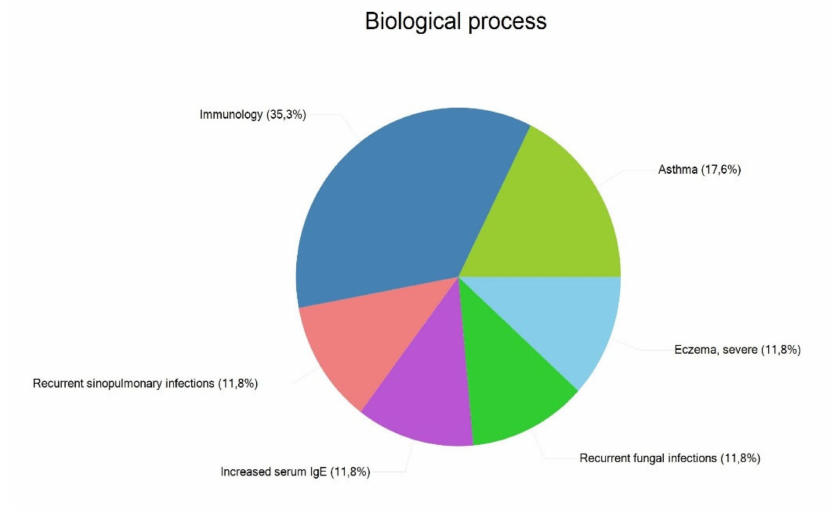
Figure 5. Most relevant biological processes involving the reported genes. Percentages indicate the number of genes with respect to total that is included in each